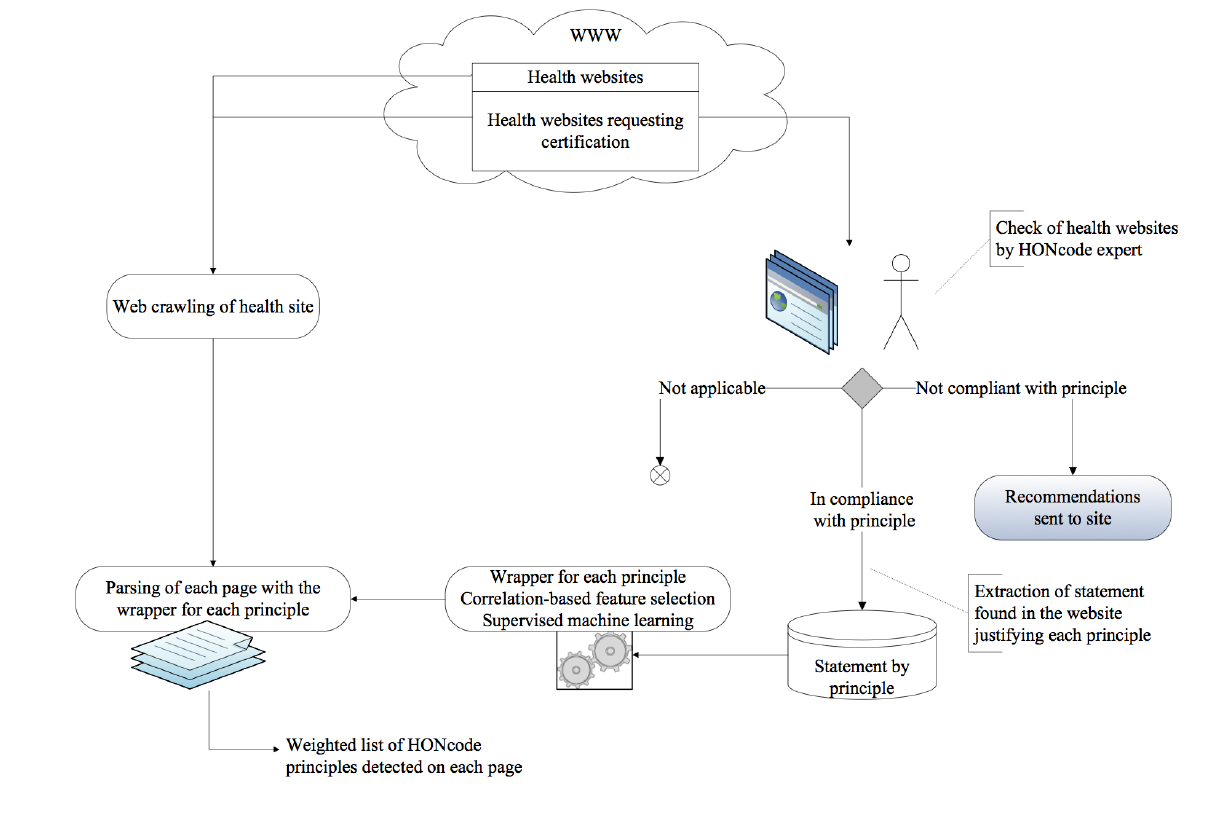
Figure 1. HONcode manual and automated detection